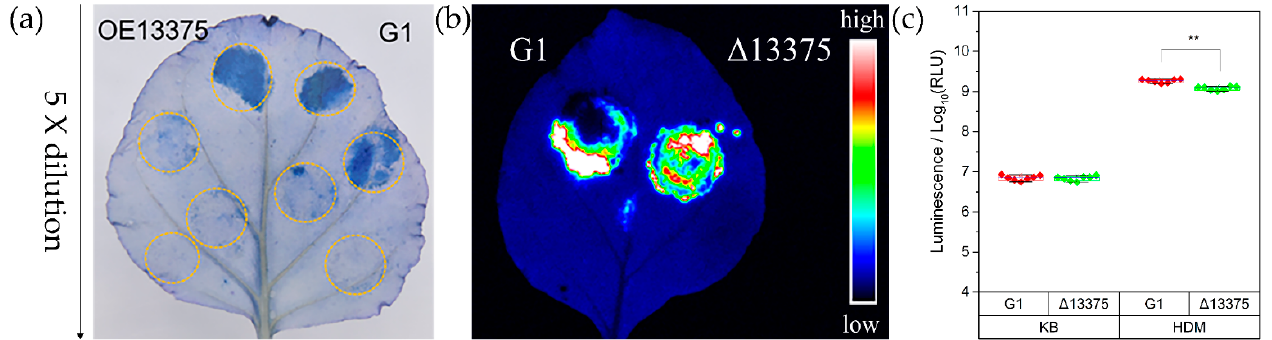
Figure 1. Overexpression of OmpR-like resulted in the attenuated capacity of G1 to elicit a hypersensitive reaction in tobacco leaves. ( a ) Strains G1 and OE13375 were individually injected into tobacco ( Nicotiana benthamiana ) leaves. Leaves were stained with trypan-blue dye after 24 h, and the initial bacterial concentration was 5 × 10 7 CFU/mL, followed by fivefold dilutions. ( b , c ) G1 and Δ 13375 with a luciferase reporter plasmid both produced bright fluorescence when injected into tobacco leaves, and the level of luciferase expression of Δ 13375 was slightly but significantly lower than that of G1 in HDM for 6 h, (**, p < 0.01, Student’s t test). G1: wild-type strain; Δ 13375: OmpR-like deletion mutant; OE13375: OmpR-like overexpression mutant.